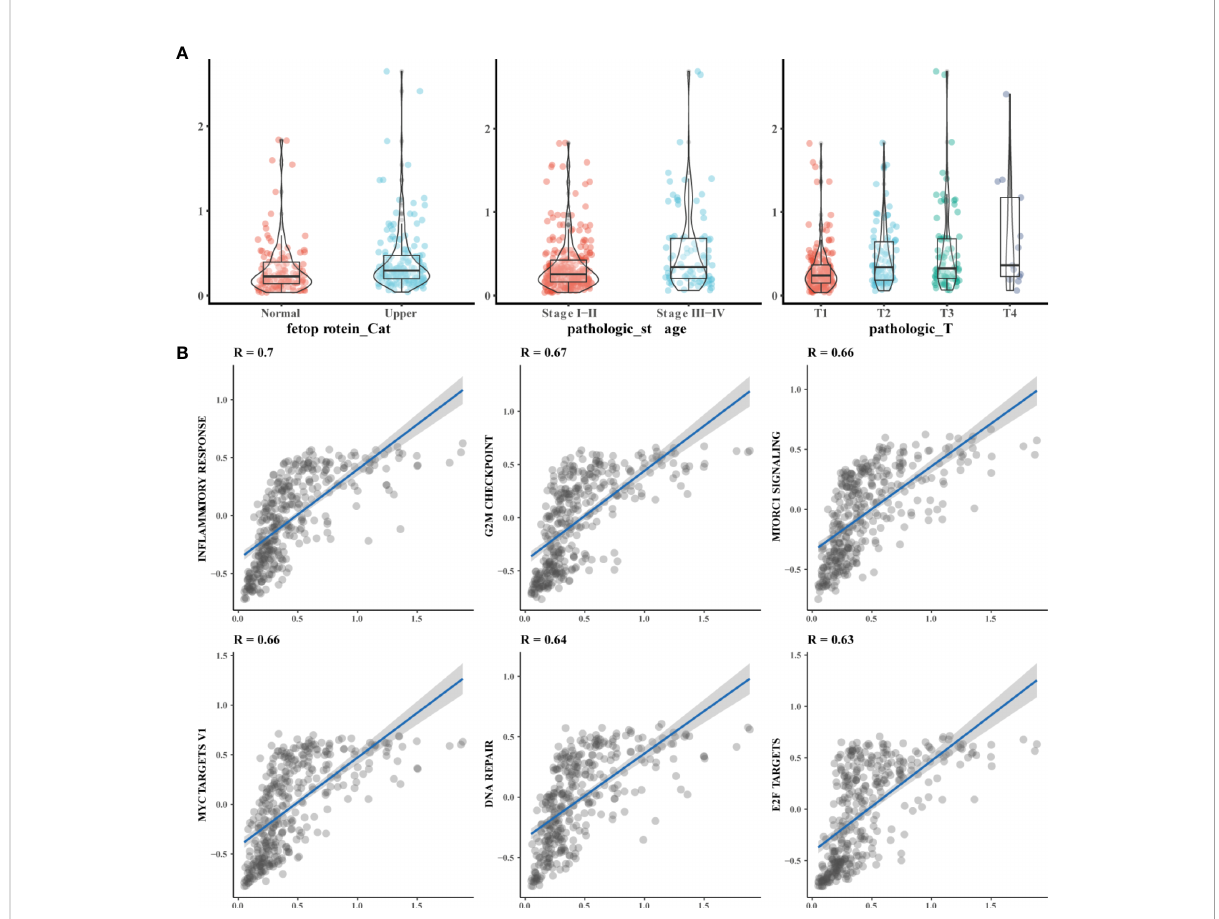
FIGURE 7 Functional of prognosis related model function. (A) The model score is correlated with the severe of clinical parameters Alpha-fetoprotein abnormalities, the higher the pathologic stage and the higher the T stage, the higher the prognostic model score; (B) The Model was mainly related to the in fl ammatory response and other pathways. GSVA scores were performed on tumor-related pathways, and the correlation between model scores and tumor-related pathways was observed through correlation analysis of pathway scores and model